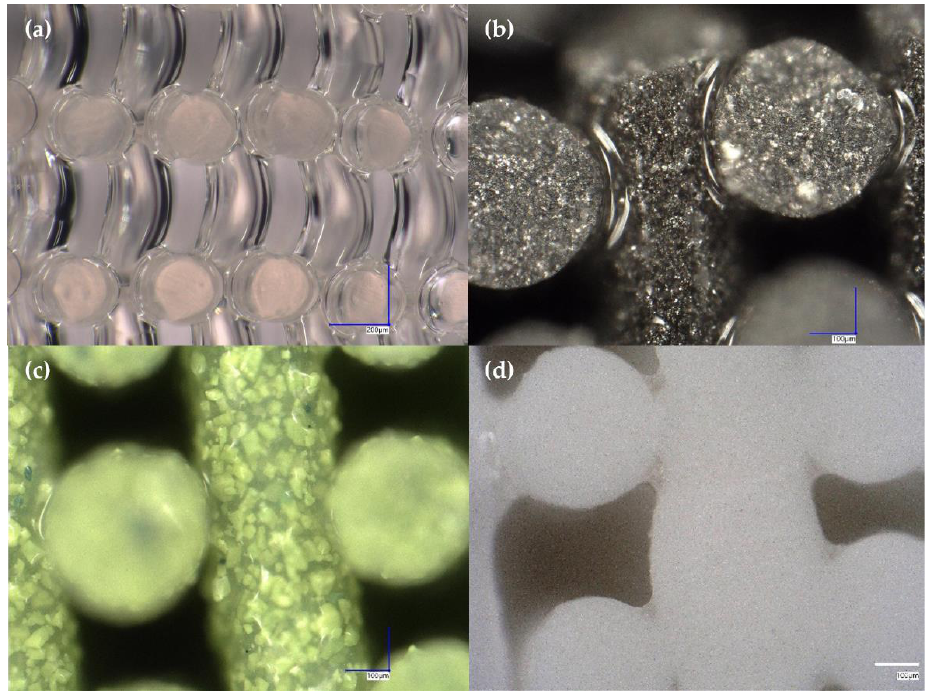
Figure 11. Microscope images of DIW prints made with: ( a ) A300 ink, ( b ) 60 wt% W ink, ( c ) 60 wt% WO 3 ink, and ( d ) 60 wt% Gd 2 O 3 ink.